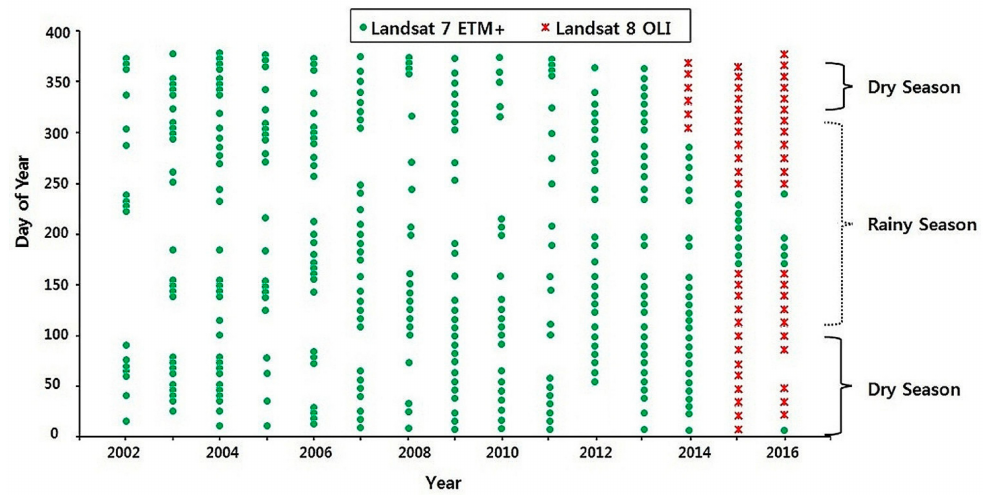
Figure 3. Temporal distribution of Landsat images used in this